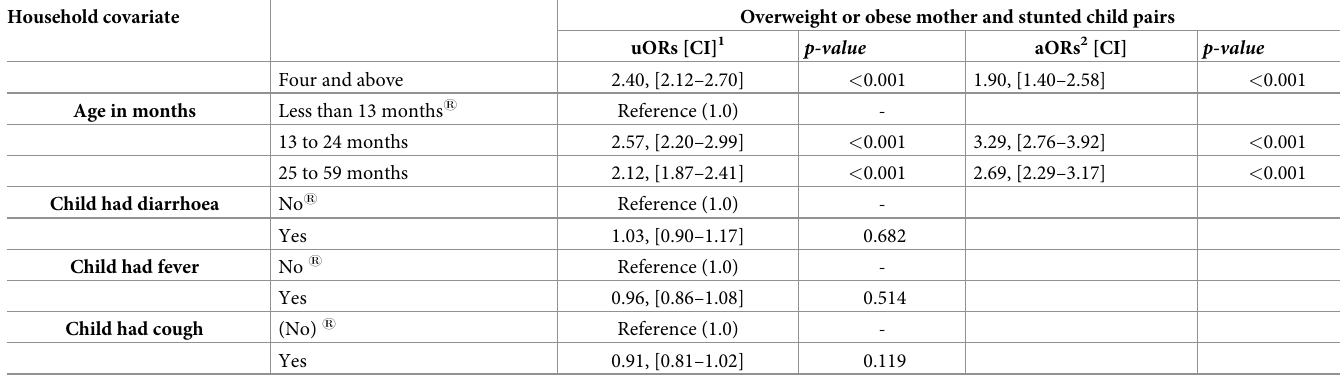
1 . Odds ratios and confidence interval at 5% significance level of bivariate regression models. 2 . Odds ratios in multivariable model after adjusting for the variables which were significant at 5% level in bivariate